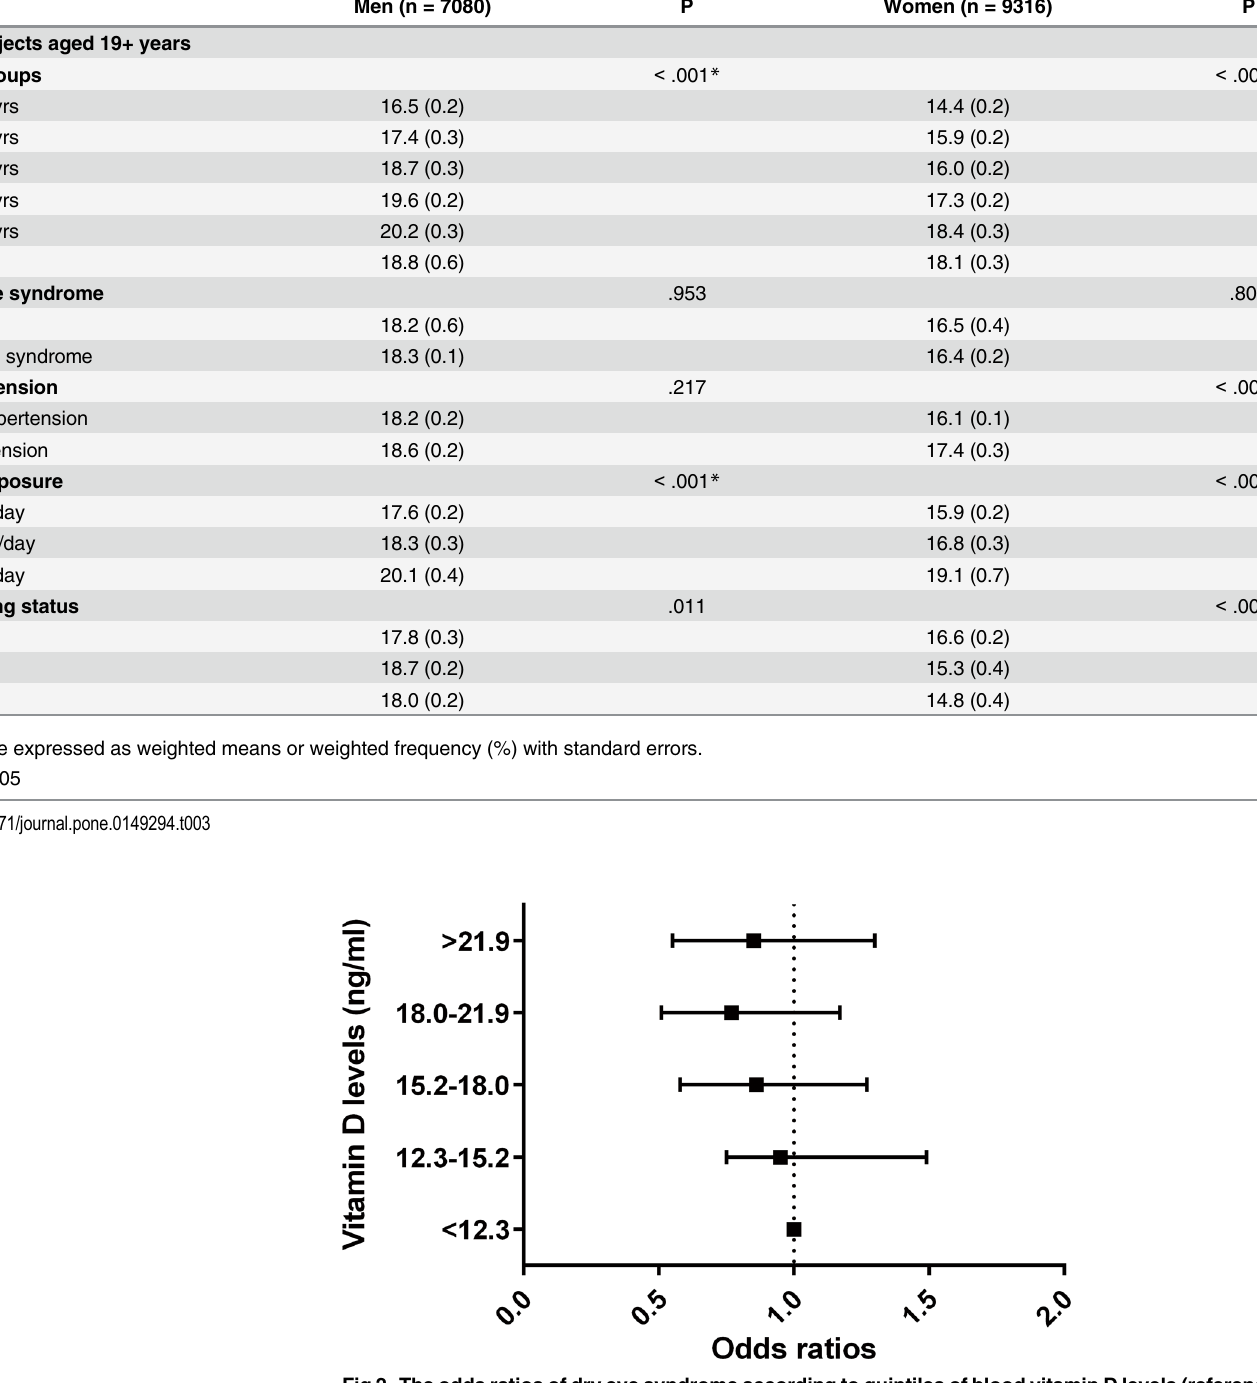
Fig 2. The odds ratios of dry eye syndrome according to quintiles of blood vitamin D levels (reference group = < 12.3 ng/ml)